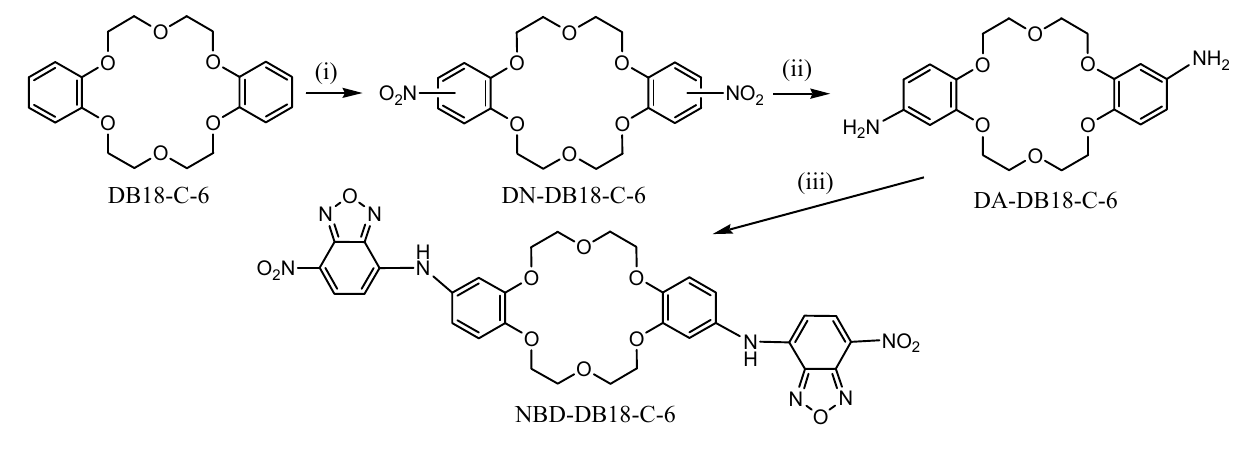
Figure 1. Synthesis of bis- NBD-DB18-C-6: ( i ) nitric acid in acetonitrile; ( ii ) hydrazine and Raney Ni in DMF; ( iii ) NBD-Cl and sodium hydrogen carbonate in acetonitrile. The last step of the synthesis was the derivatization of the diamine with